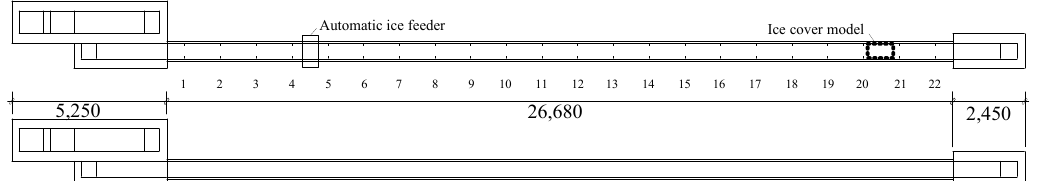
Figure 2. Layout plan of the flume for experiments.